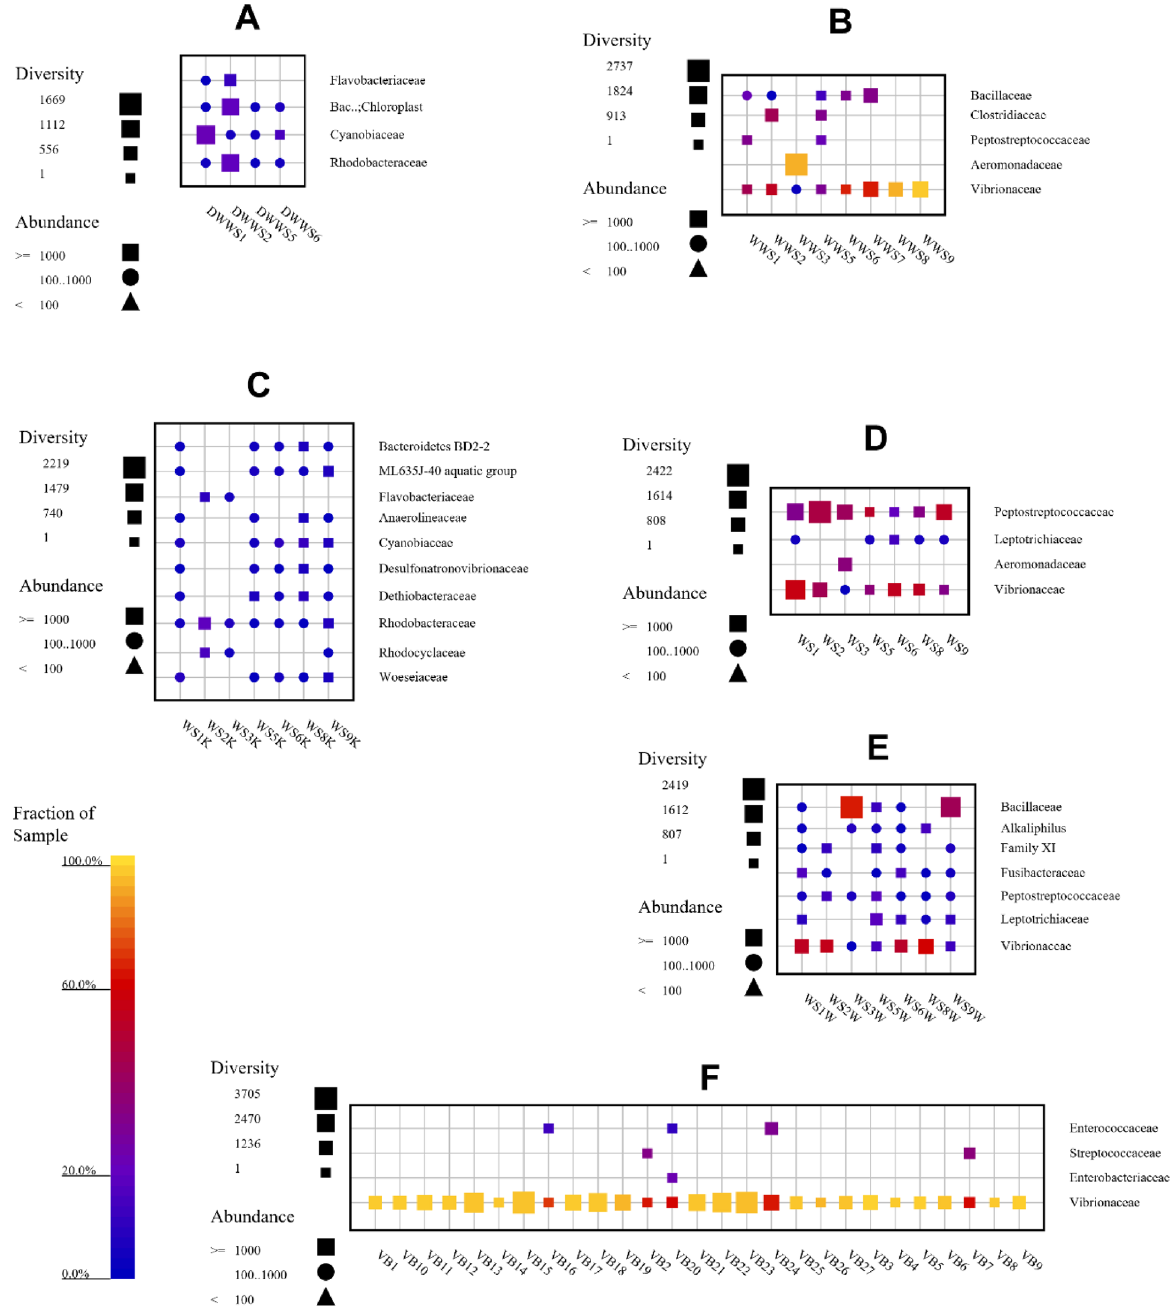
Figure 2. Family-level taxonomic fingerprint of ( A ) directly studied water samples (DWWS1–DWWS6), ( B ) pre-enriched water samples (WWS1–WWS9), ( C ) directly studied sediment samples (WS1K–WS9K), ( D ) pre-enriched sediment samples in buffered peptone water (WS1–WS9), ( E ) pre-enriched sediment samples in buffered peptone water supplemented with lake water (WS1W–WS9W), ( F ) pre-enriched fish samples (VB1– VB27) of Lake Van (The figure was created using SILVA NGS 1.4